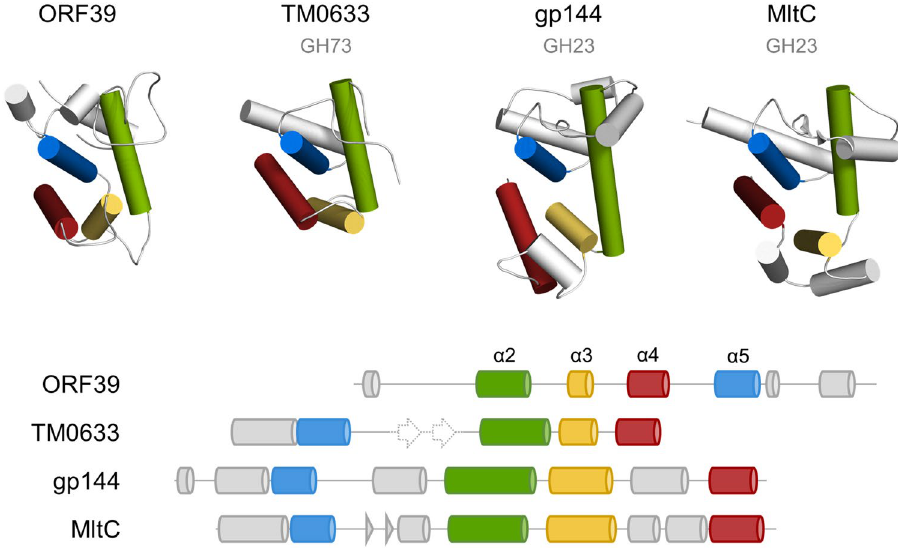
Figure 5. Similarities in the core fold of the Enc34 endolysin and GH73 and GH23 glycoside hydrolase enzymes. The Enc34 endolysin (ORF39), Thermotoga maritima TM0633, phiKZ gp144 and Escherichia coli MltC proteins are shown in the same orientation as in Fig. 4 with the four helices constituting the protein core shown in different colors. Secondary structure diagrams of the proteins are presented below using the same color scheme. A β-hairpin present in the TM0633 protein but not included in the model is shown in dashed